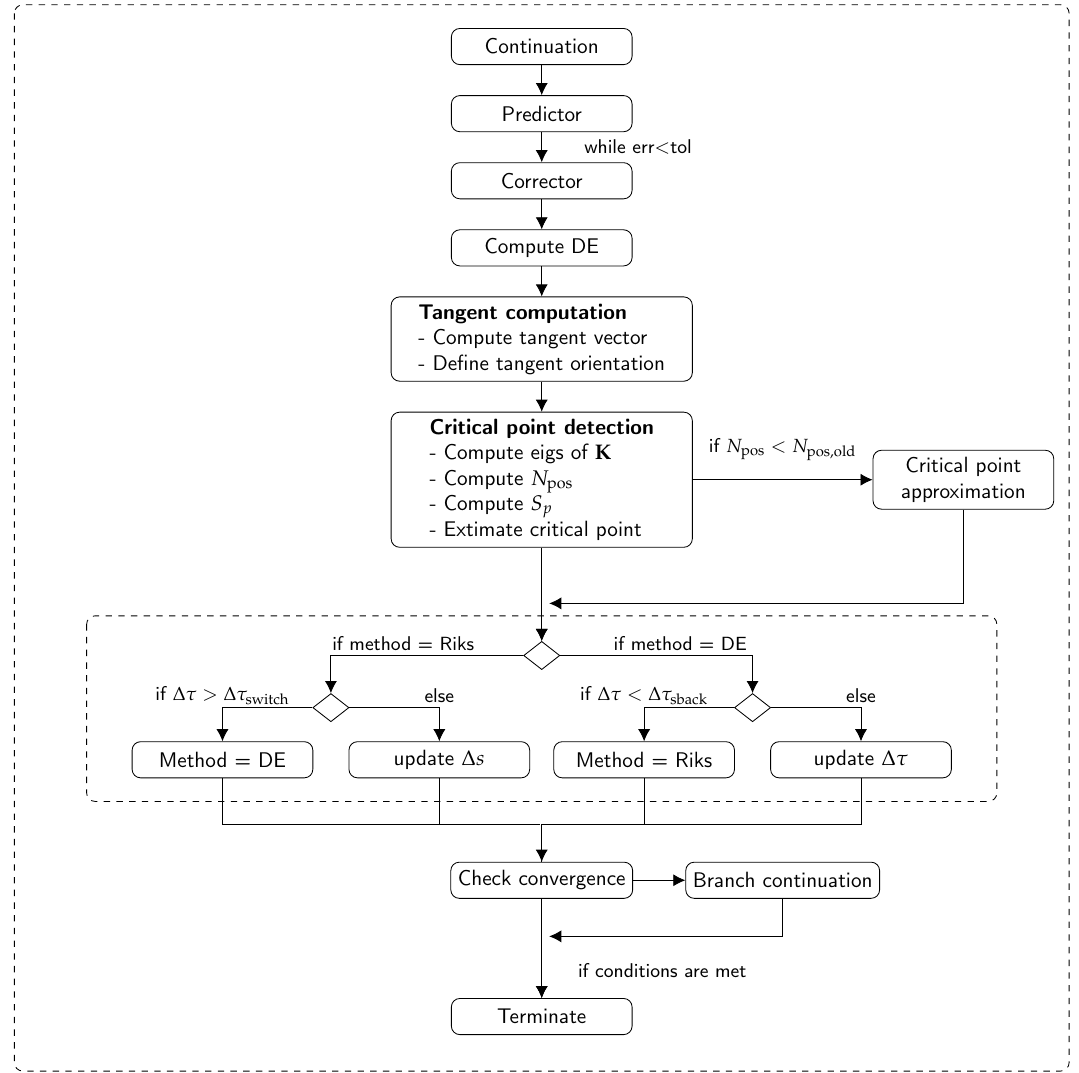
Figure 1. Flowchart of the continuation